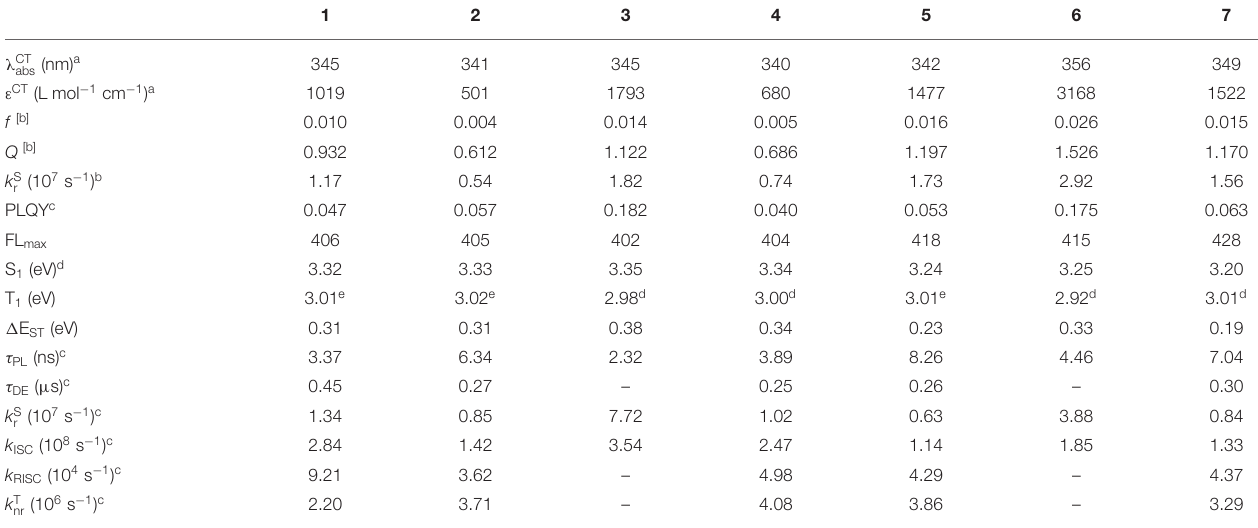
a Results from Gauss curve fitting (see Figure S2 ). b Estimated using equations reported in literature (see Supporting Information ). c Inert gas saturated conditions. d Estimated from the onset value of the spectrum. e Estimated from the shortest wavelength peak maximum in the phosphorescence